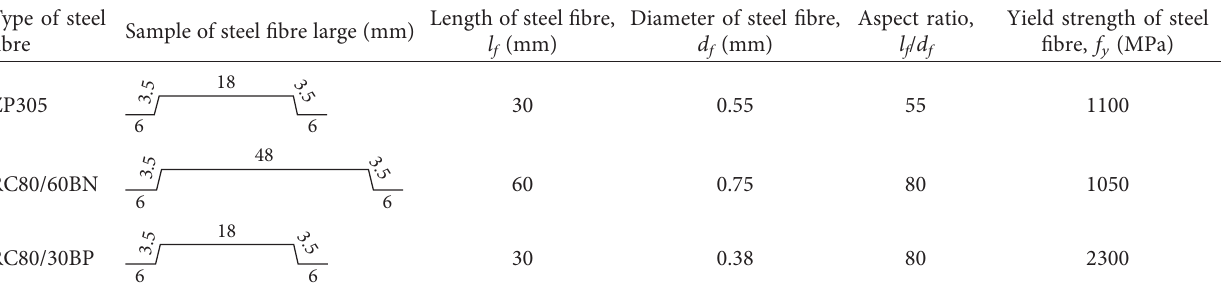
Figure 8: Four-point flexural tests of SFRC beams: (a) end view; (b) side Table 2: Properties of steel fibres.